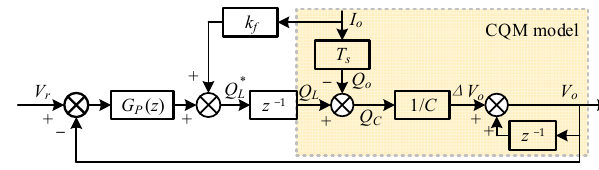
Figure 5. The DCC control diagram of a DCM inverter.